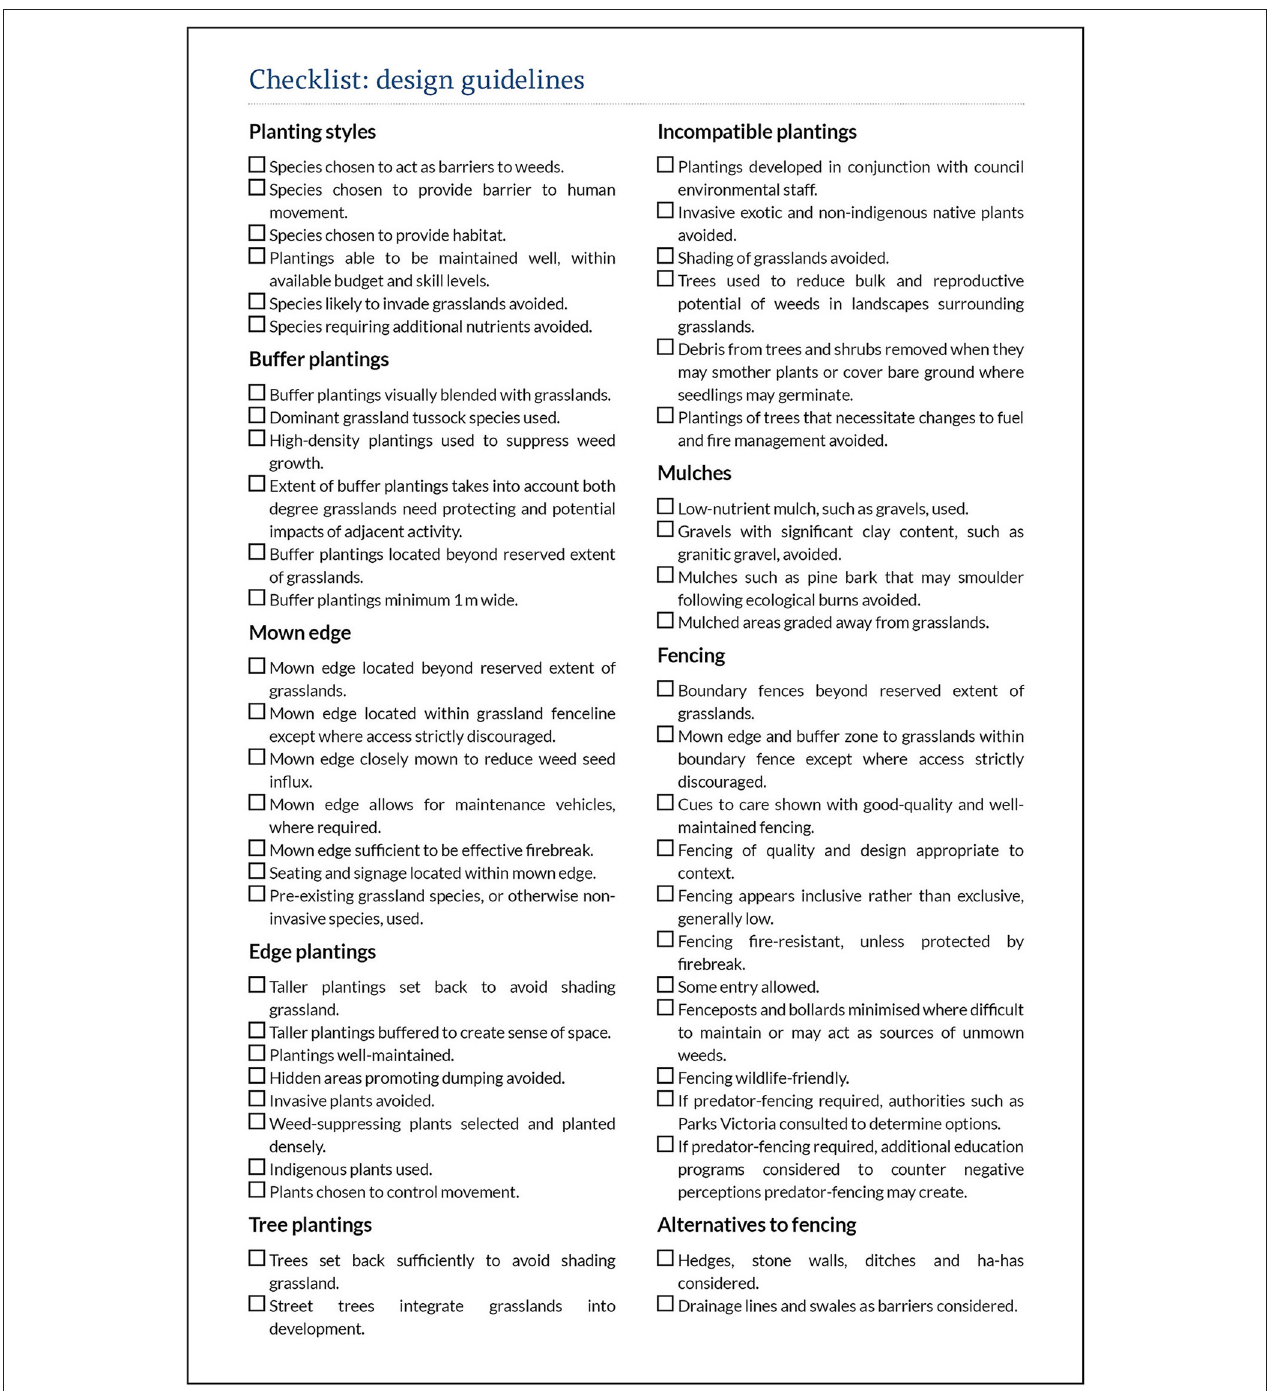
FIGURE 2 | A simple summary: A checklist from Start with the grasslands provides a simple summary of some design guidelines and is a useful tool for council staff against which to assess construction works. Image: Adrian Marshall CC